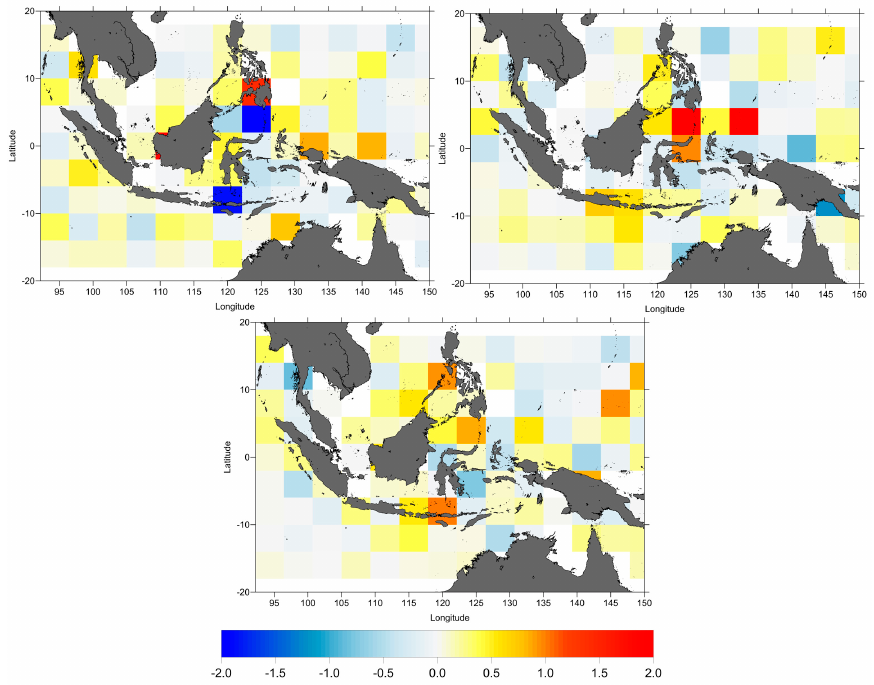
Figure 20. SLA variance differences at crossovers (cm 2 ), between DTU13 and CNESCLS2011 MSS